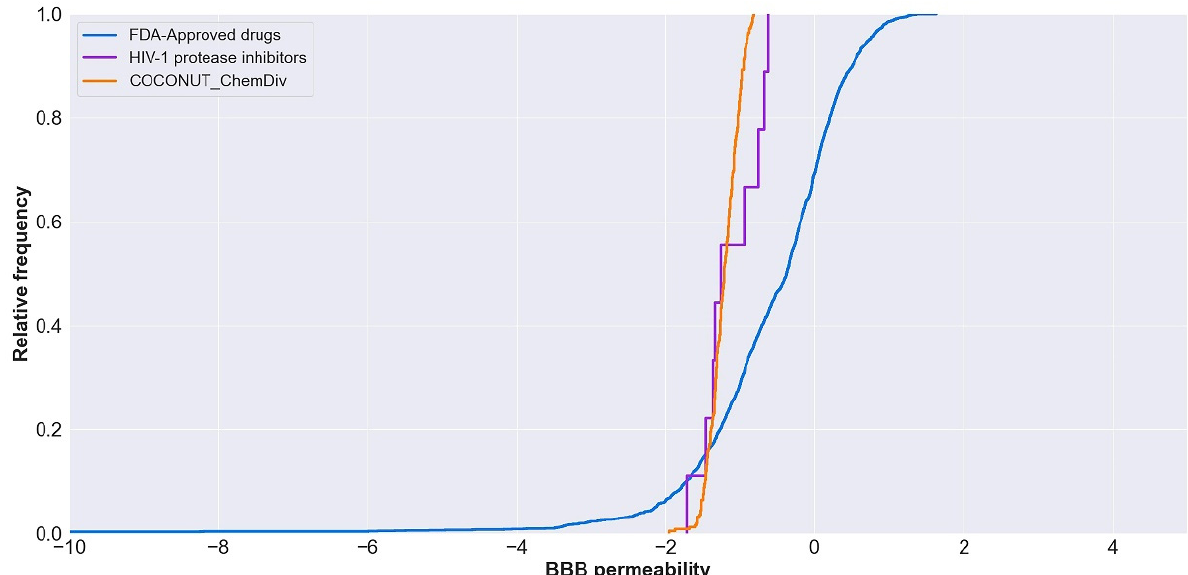
Figure 11. Distribution curve of BBB permeability. Colors represent compounds: new chemical compounds generated from COCONUT fragments and ChemDiv fragments with physicochemical properties like FDA-approved HIV-1 protease inhibitors and easily synthetically accessible (orange), FDA-approved drugs (blue), FDA-approved HIV-1 protease inhibitors (purple). The BBB permeability of FDA-approved drugs was between − 34 and 2.